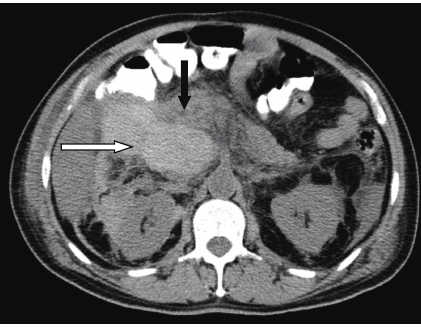
Figure 2: CT of abdomen revealed a large hematoma inferior and medial to the liver (white arrow) and abutting the pancreatic head (black arrow).